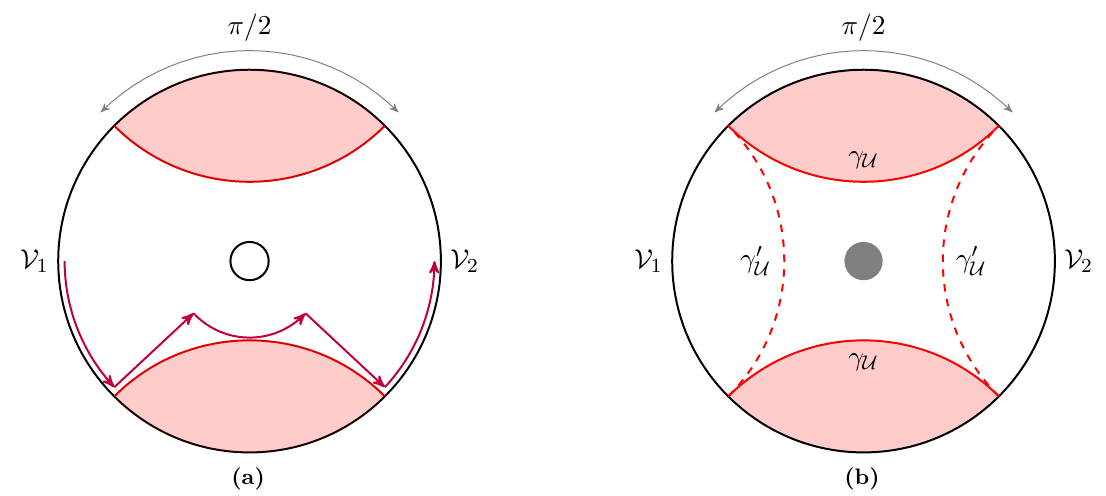
Figure 4. (a) Top down view of a causal curve constructed in the BTZ geometry from point c at φ = 0 , t = − 3 π/ 4 to the boundary at φ = π . For a small enough black hole, the curve reaches φ = π before the point r , which is at time 3 π/ 4 . The curve is constructed to avoid E appendix C for details. (b) An example with degenerate minimal extremal surfaces, constructed by starting with AdS . A small amount of matter with O (1) entropy has been added to the bulk. 2+1 Surfaces γ (red) and γ 0 (dashed red) have the same U U